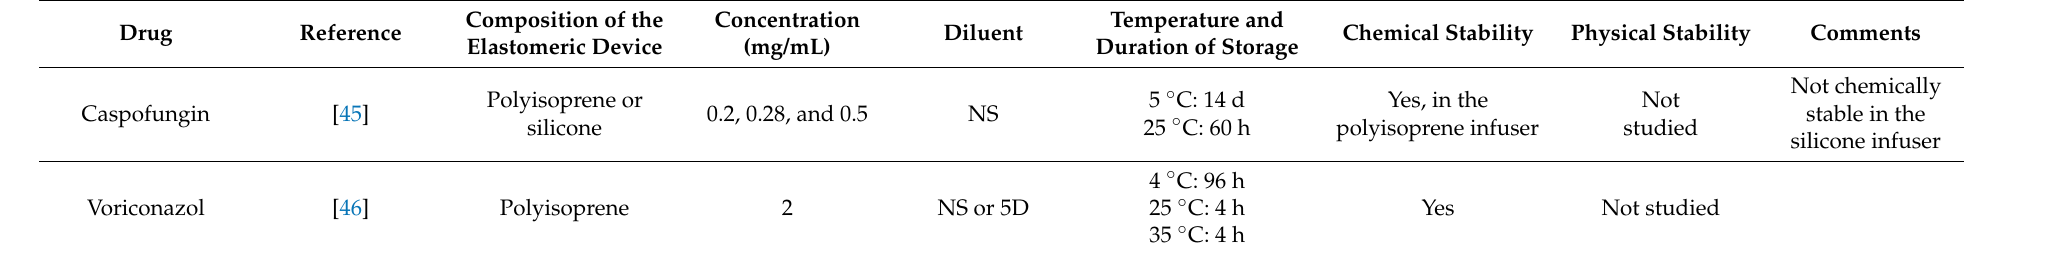
Table 7. Stability of antifungals in elastomeric devices.